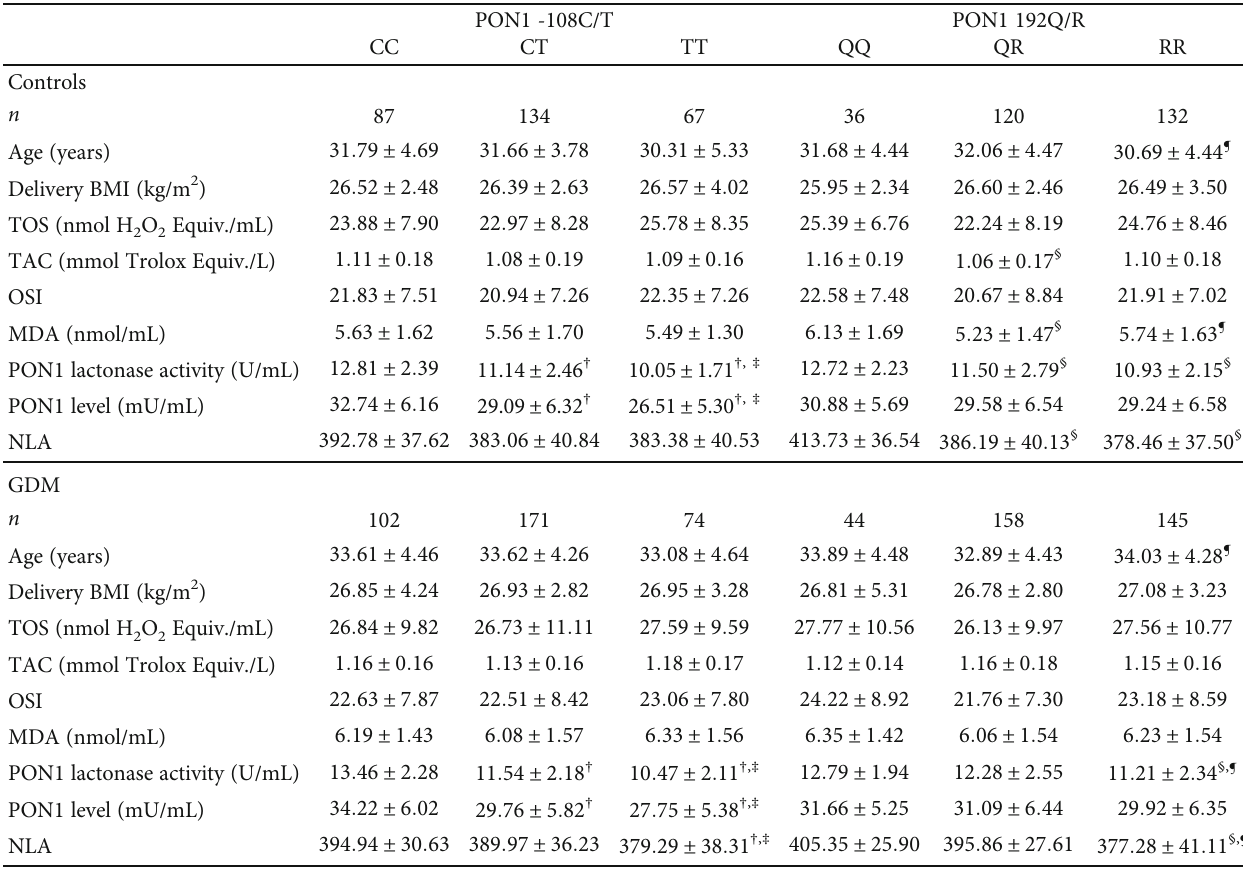
Table 4: Lactonase activity, level, and NLA of PON1 and markers of oxidative stress according to PON1 genetic polymorphisms in the women with GDM and the women with uncomplicated